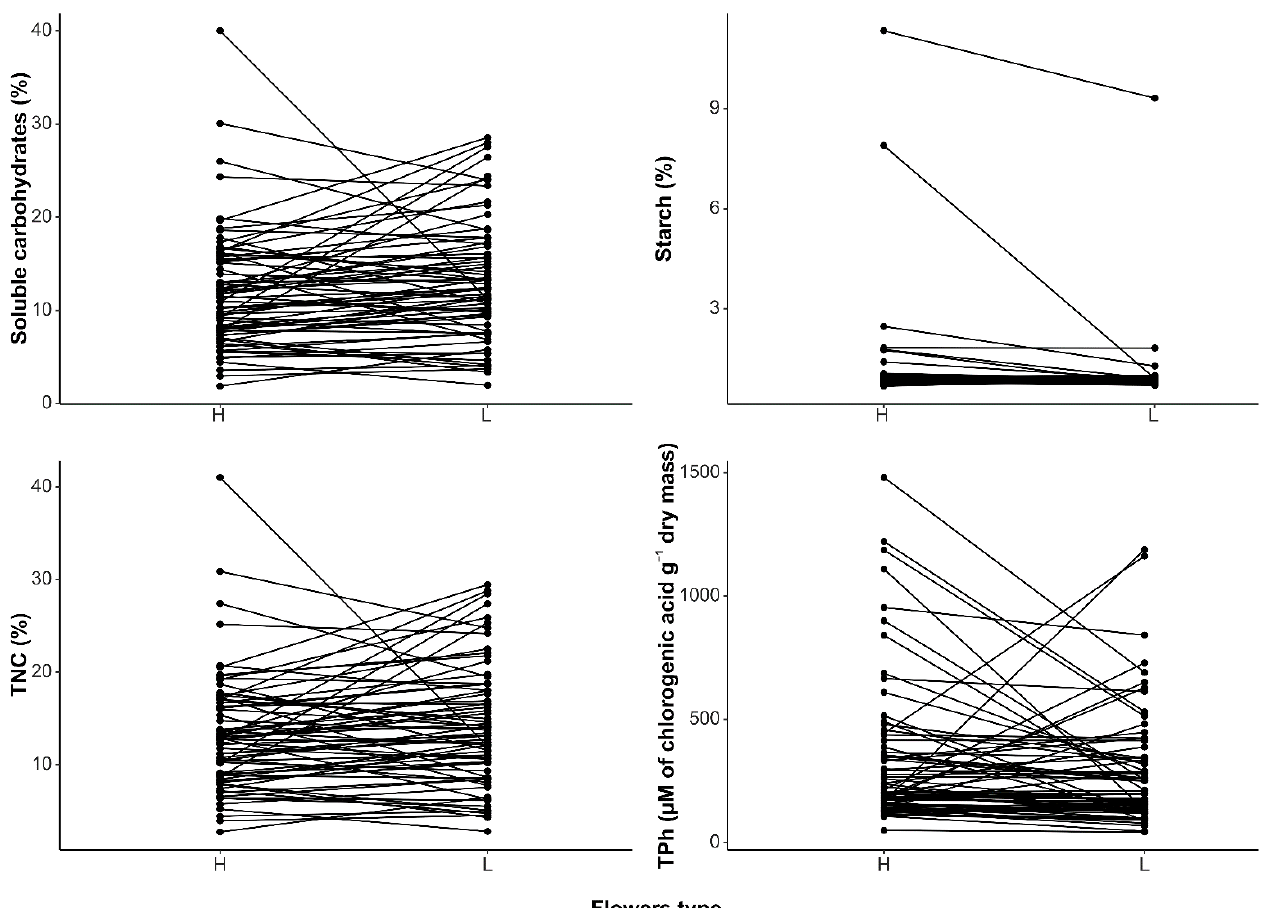
Figure 3. Observed soluble carbohydrates, starch, TNC, and TPh species-wise differences between high-light (H) and low-light (L) parts of the crown. Each line represents the slope of a trait difference for a particular species.